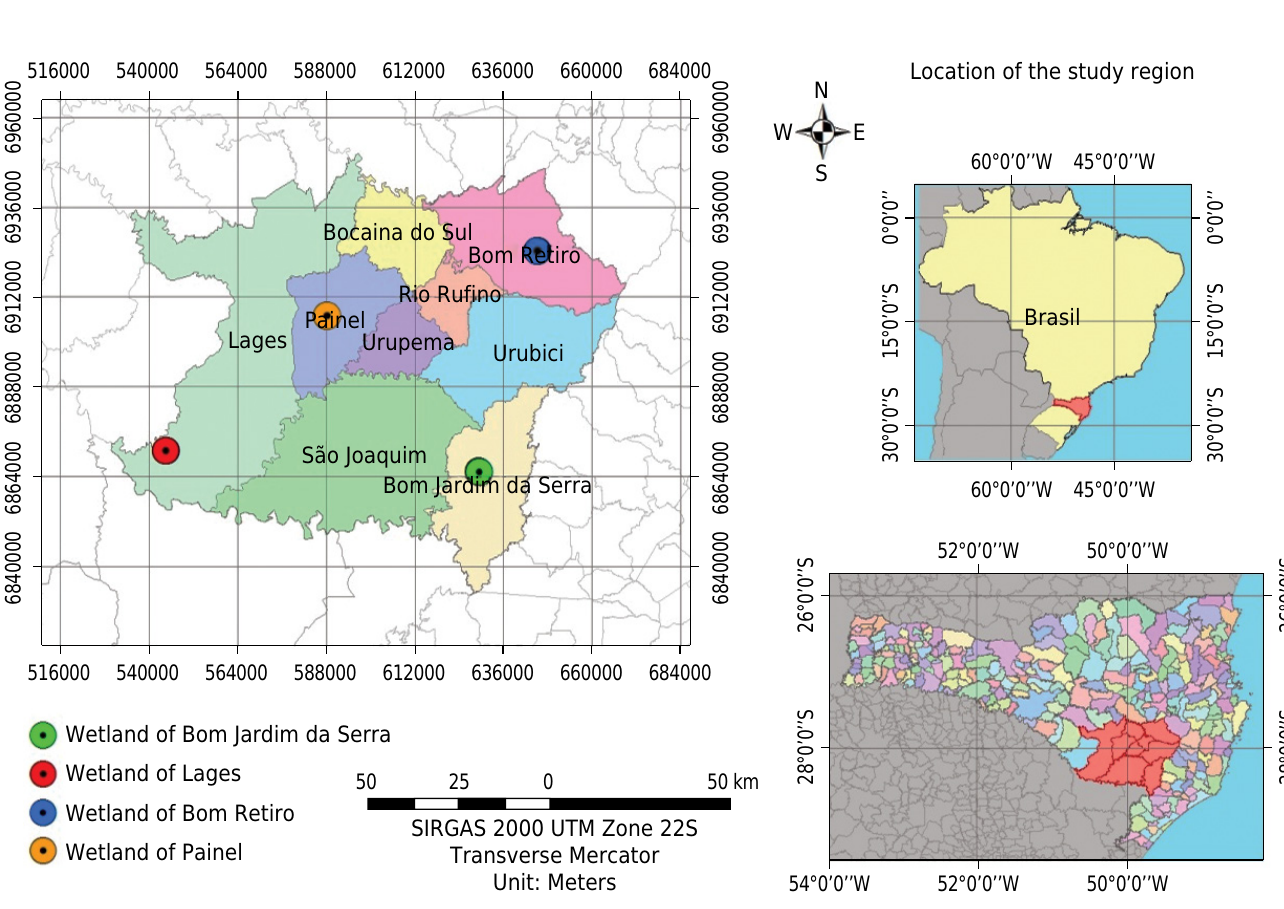
Figure 1. Location of the wetlands studied in the state of Santa Catarina. BJS: Bom Jardim da Serra; BR: Bom Retiro; LGS: Lages; PA: Painel. Figure of the Aerophotogrammetric Survey of the state of Santa Catarina, Brazil,